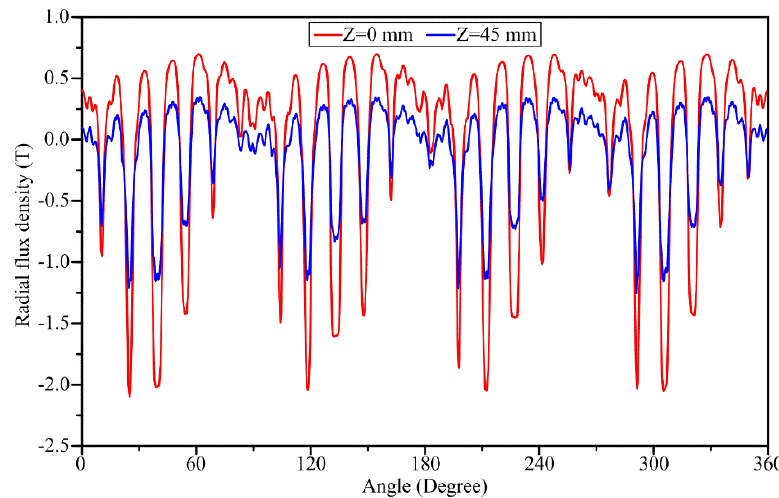
Figure 10. Two-dimensional (2D) radial flux density in the air-gap in the optimum